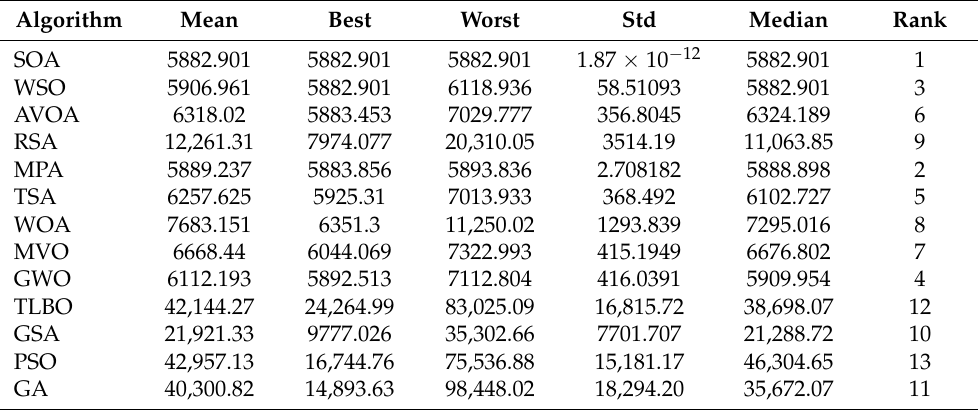
Table 10. Statistical results of optimization algorithms on pressure vessel design problem.